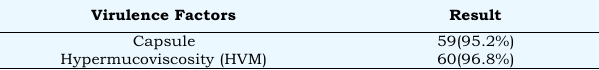
Table 5 Virulence factors among 62 K. pneumoniae